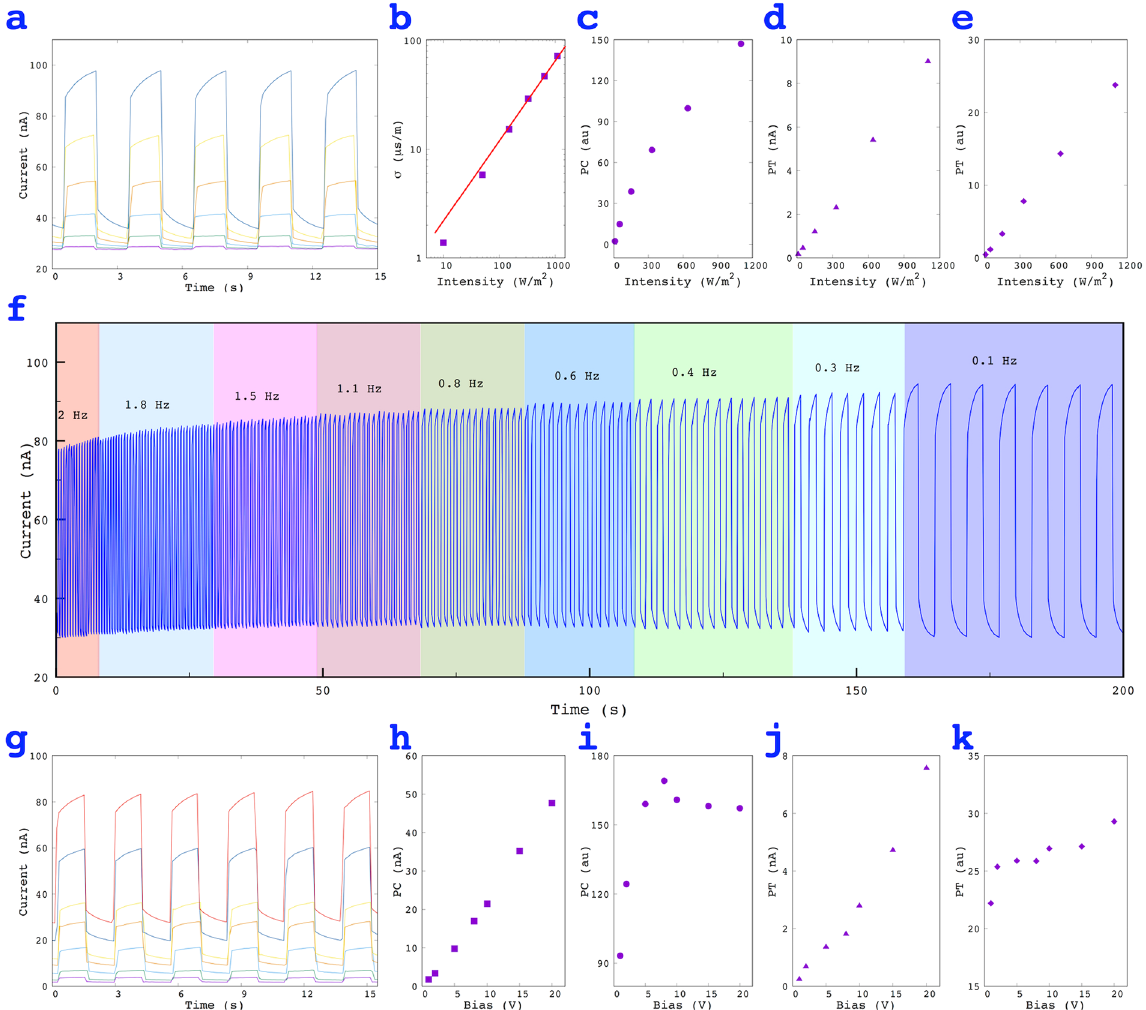
Figure 3. Photoresponse of a MoS 2 film under various conditions. ( a ) Time-resolved photoresponse of a 10 × 2 mm film for various light intensities, ( b ) and ( c ) The absolute and normalized photocurrent change, PC (nA) and PC (au), ( d ) and ( e ) The absolute and normalized photothermal effect, PT (nA) and PT (au), ( f ) Time resolved photoresponse of a MoS 2 film for various pulse light frequencies, ( g ) Time resolved photoresponse of a 10 × 2 mm film for various biases, ( h ) and ( i ) The absolute and normalized photocurrent change, PC (nA) and PC (au), ( j ) and ( k ) The absolute and normalized photothermal effect, PT (nA) and PT